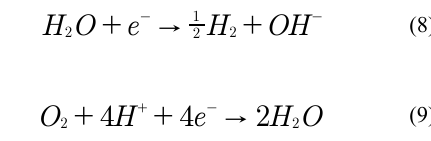
, %), thickness (h, mm) and copper and cobalt contents (wt. % Cu and wt. % Co) in the f